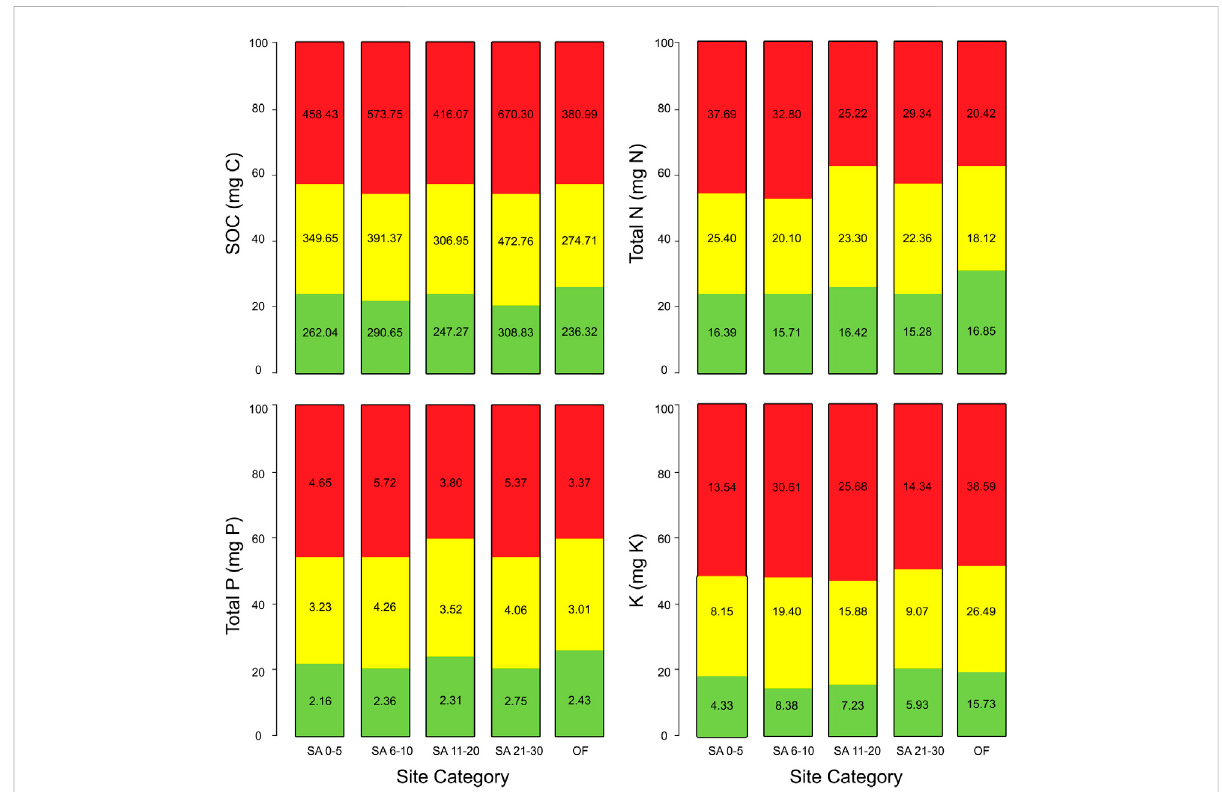
FIGURE 2 The relative contribution of soil C and other nutrients at different soil depths in our sites on Leyte Island, the Philippines. The Y -axis here indicates the percentage (%) contribution to the total soil carbon and nutrients pools at the three soil depths studied. The values within the bars are soil macronutrients (mg) in different site categories adjusted after respective bulk density and soil